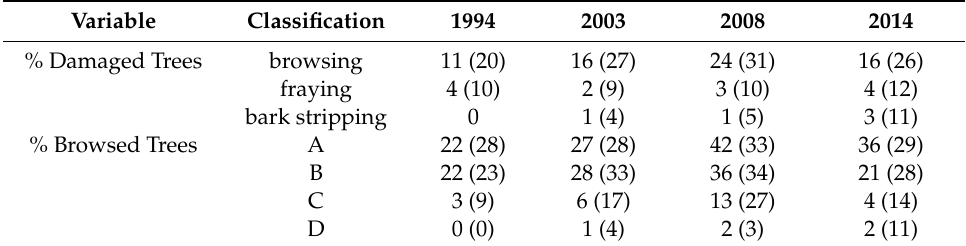
Table 1. Mean values of percentage of damaged trees per damage type within the plots and mean values of percentage of browsed trees for size classes (A–D). Standard deviation is reported in parentheses as a measure of statistical